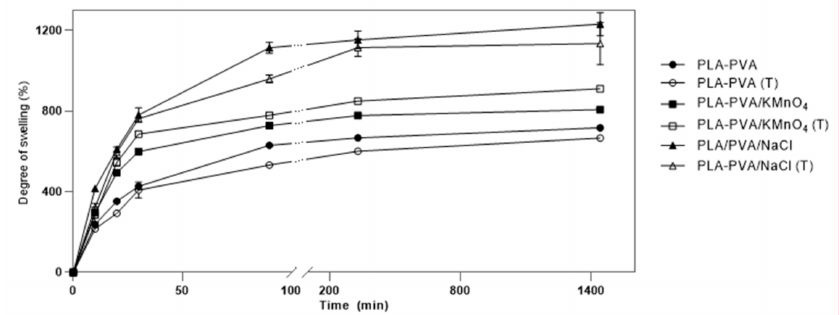
Figure 7. Swelling studies of the porous bioscaffolds in phosphate-buffered saline (PBS) with pH 7.4 at 37 ◦ C.